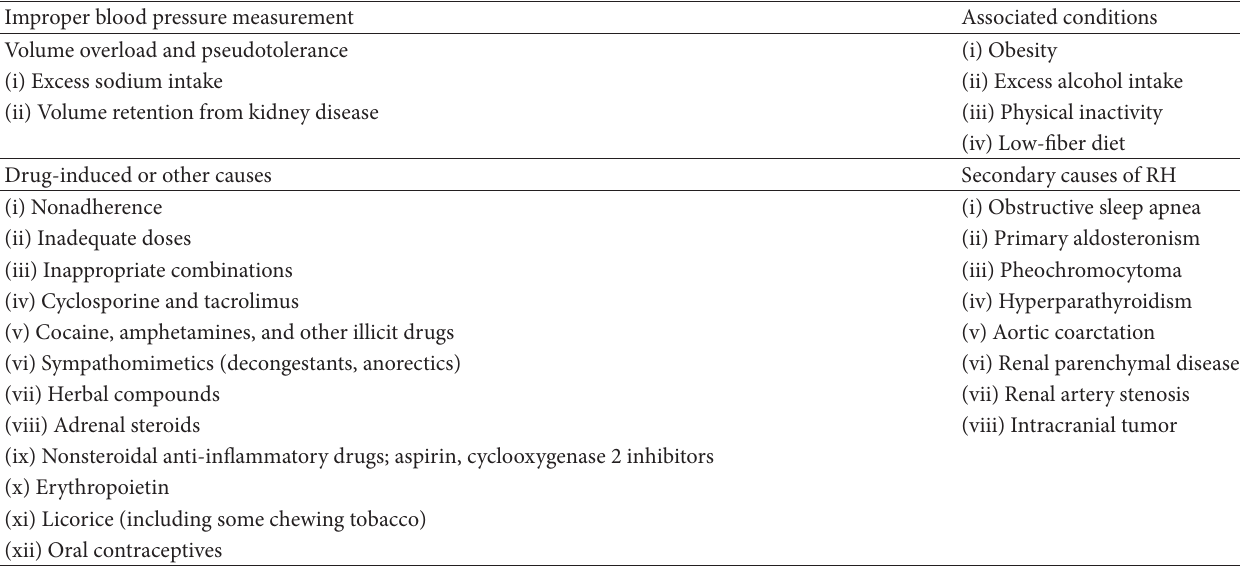
Table 1: Causes of